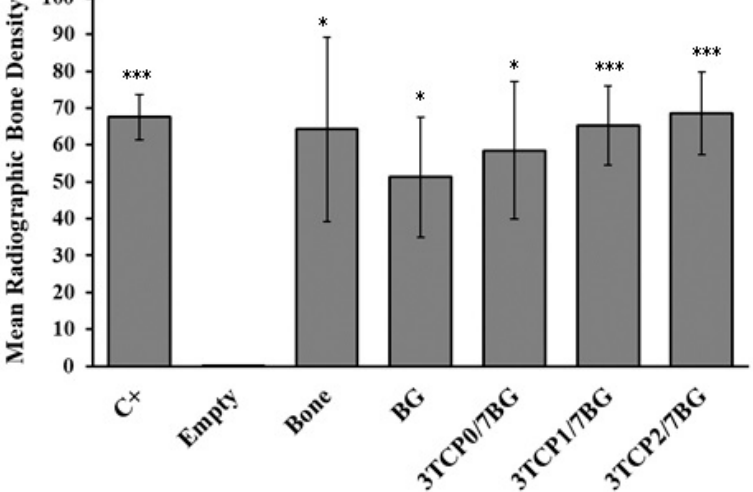
Figure 5. Radiographic bone density of excised bone defects and non-manipulated bone (positive control, C+) evaluated after 9 weeks post-implantation. The figure represents the mean and standard error of at least 5 independent experiments. Statistically significant differences were obtained between the empty defect and the other groups. These differences are identified with the use of * that represents p < 0.05 and *** that represents p < 0.001.